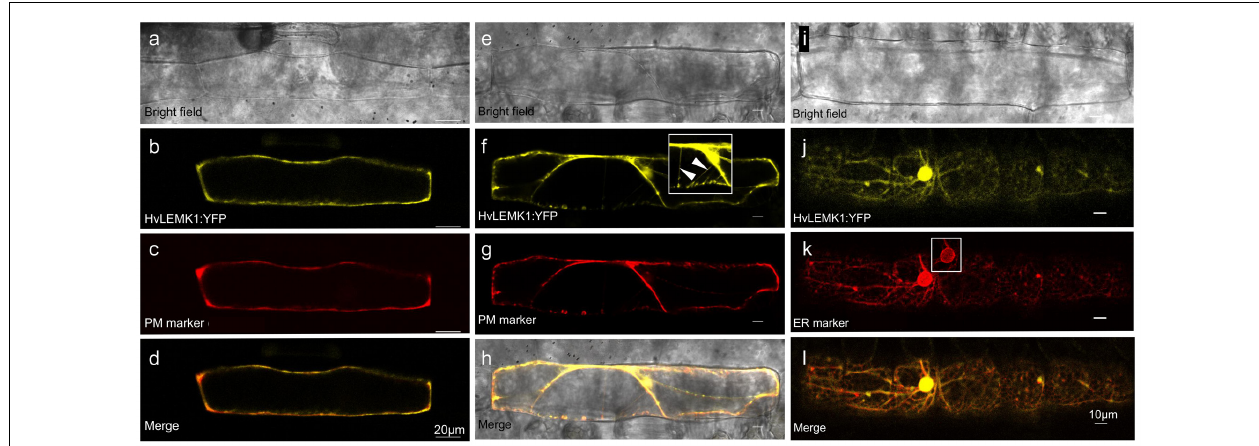
FIGURE 2 | Localization of C-terminal Hv LEMK1:YFP fusion protein in barley epidermal cells. Barley leaf segments were co-bombarded with plasmids encoding HvLEMK1:YFP and the plasma-membrane localization marker pm-rk CD3-1007 (encoding aquaporin) or the endoplasmic reticulum-localization (ER) marker ER-rk CD3-959 (encoding AtWAK2 ) (Nelson et al., 2007). Confocal laser-scanning microscopy of non-inoculated cells was performed 24 h after the bombardment. (a–d) co-localization with the plasma-membrane marker. (e–h) plasma-membrane localization confirmed in plasmolysed cells. The inset in (f) corresponds to an over-exposed section of (f) , showing localization to Hechtian strands (arrowheads). (i–l) Co-localization with the ER marker. The inset in (k) corresponds to the cell nucleus imaged with reduced brightness in order to reveal the expected accumulation of the ER-marker at the nuclear border.